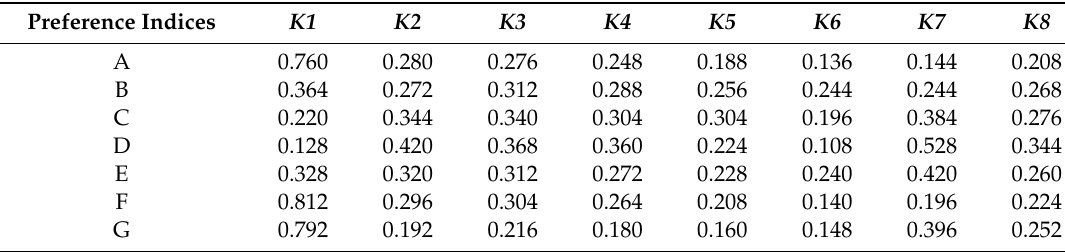
Table 3. Indices of preference for service centers.